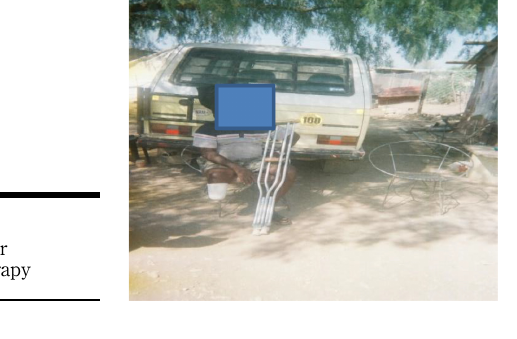
Figure 1. Referral for